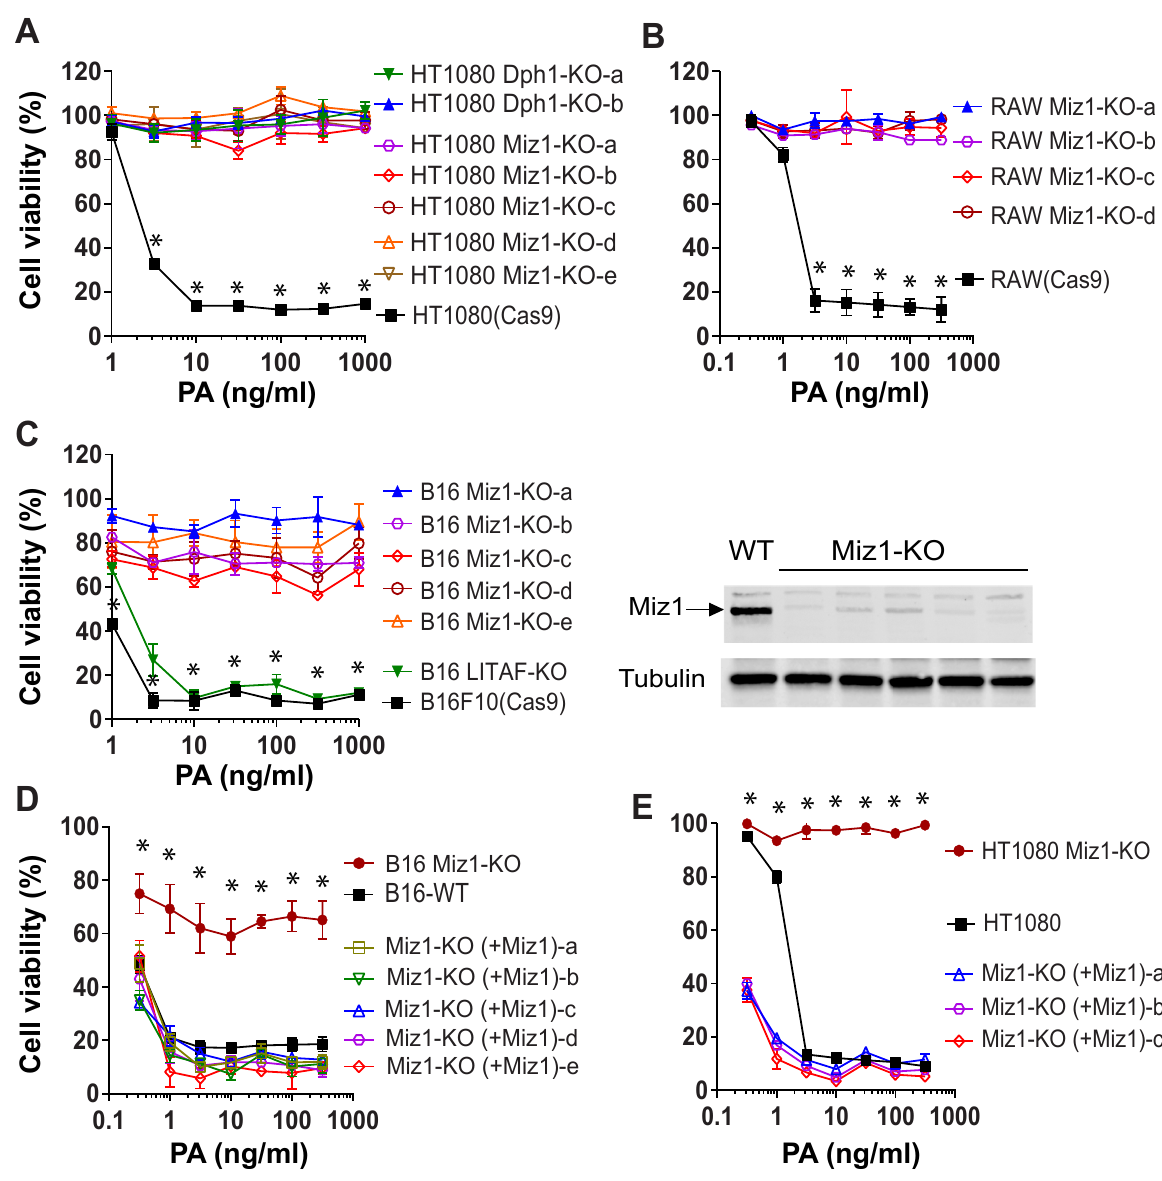
Fig 2. Miz1-decificent cells are resistant to PA/FP59. A - C . Knockout of Miz1 in HT1080 (A), RAW264.7 (B), and B16F10 (C) cells by CRISPR gene editing rendered these cells resistant to PA/FP59. The results from several independent clones are shown. In (A), knockout of Dph1 was used as an additional control. The indicated cells were incubated with various concentrations of PA in the presence of FP59 (100 ng/ml) for 48 h, followed by an MTT assay evaluating cell viability. Right panel in (C), lacking of Miz1 expression in representatives of B16 Miz1-KO clones was confirmed by Western blotting using an anti-Miz1 antibody (R&D Systems Cat. No. AF3760). Data are represented as mean (triplicate) ± SD. Unpaired two-tailed Student’s t -tests, � , p < 0.001 between wild-type HT1080 (in A), RAW264.7 (in B), or B16F10 (in C) cells and their isogenic Miz1-KO or Dph1-KO cells. D and E . Reversion of the toxin-resistant phenotype of the B16 Miz1-KO cells (D) and HT1080 Miz1-KO cells (E) by transfection of a Miz1-expression plasmid. The results from several independent clones are shown. Cells were incubated with various concentrations of PA in the presence of FP59 (100 ng/ml) for 48 h, followed by an MTT assay evaluating cell viability. Of note, the Miz1-KO cells transfected with Miz1 regained their sensitivity to the toxin. Data are represented as mean (triplicate) ± SD. Unpaired two-tailed Student’s t -tests, � , p < 0.001 between B16F10 Miz1-KO (in D) or HT1080 Miz1-KO (in E), and their isogenic Miz1 transfected